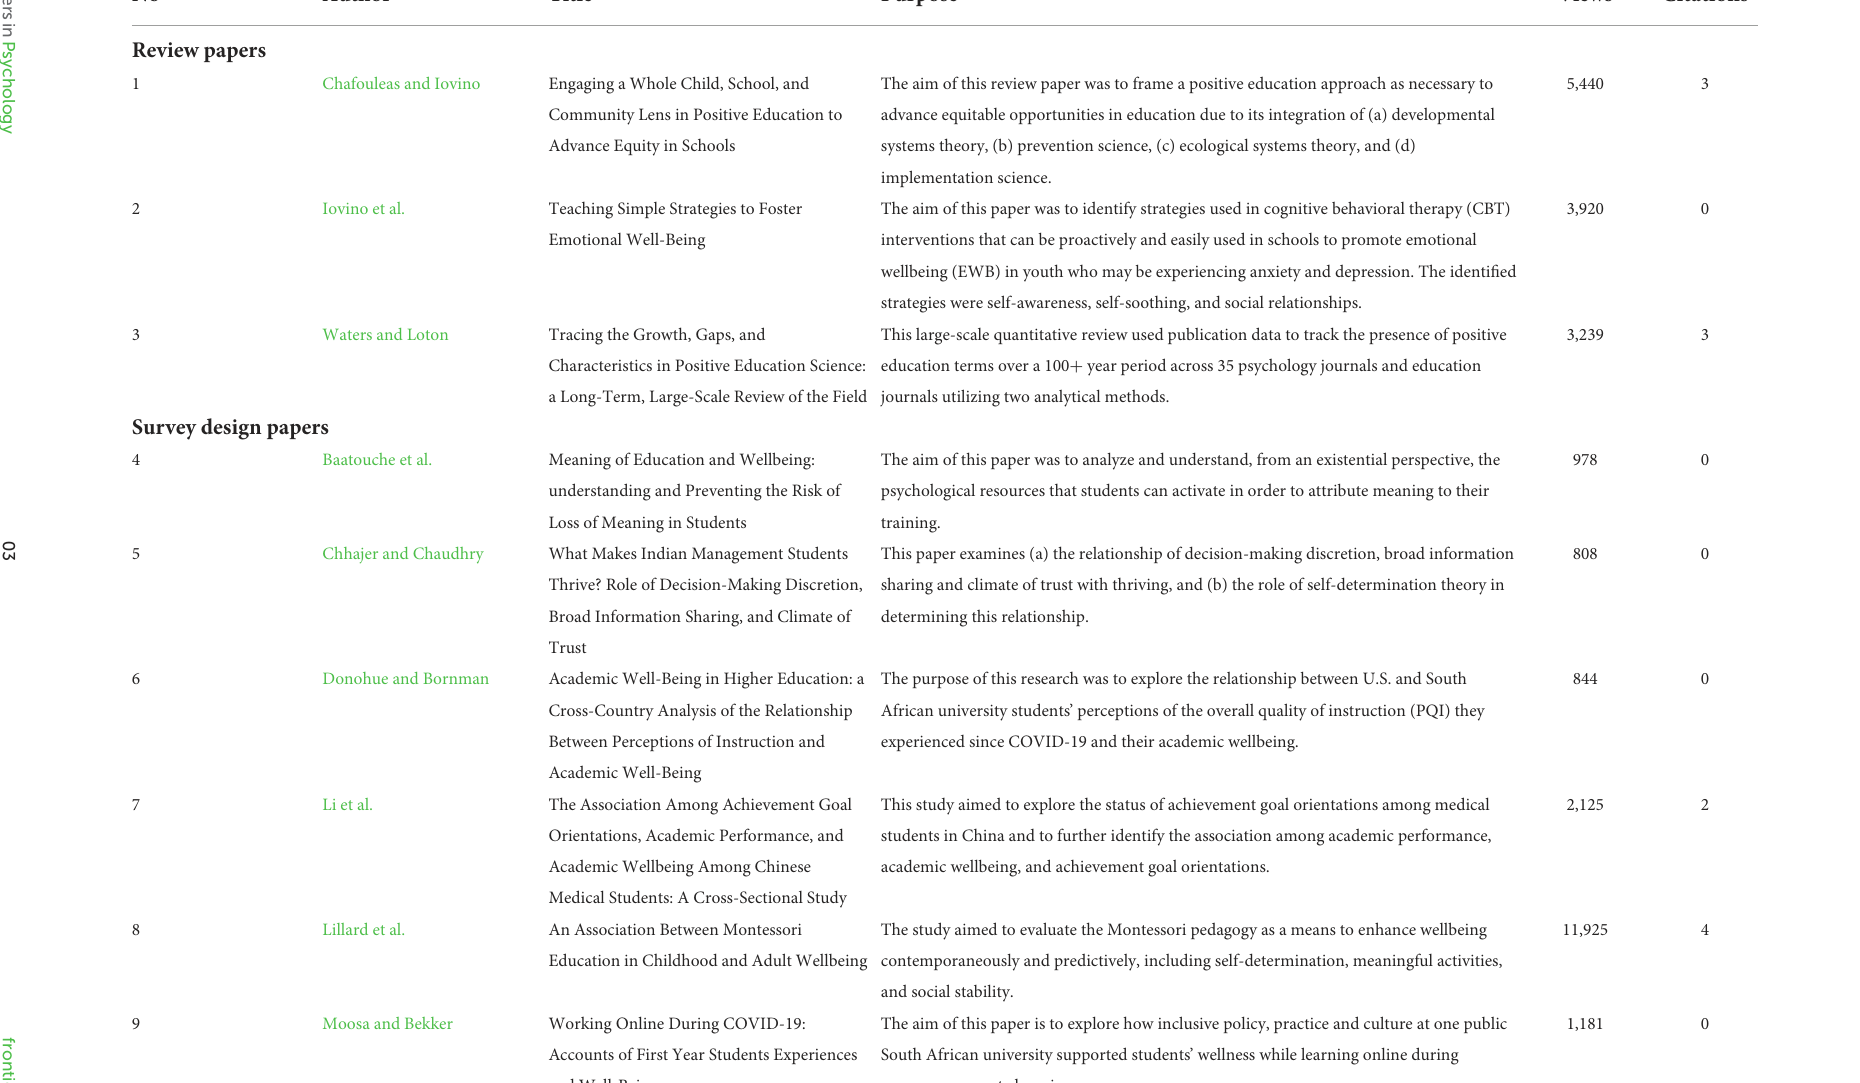
TABLE 1 Summary of contributions to the Research